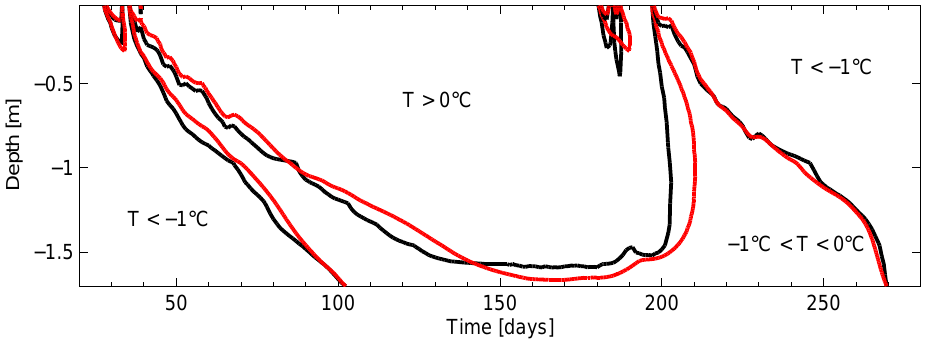
Fig. 10. Simulation results for the Tianshuihai site in the summer black: measured data, red: conduction with a water distribution that is constant in time, scenario of 2008. Shown are the 0 ◦ C and the − 1 ◦ C isotherms. The colors represent: Black: Measured data, red: Conduction with a water distribution that is constant in time, scenario (iii).